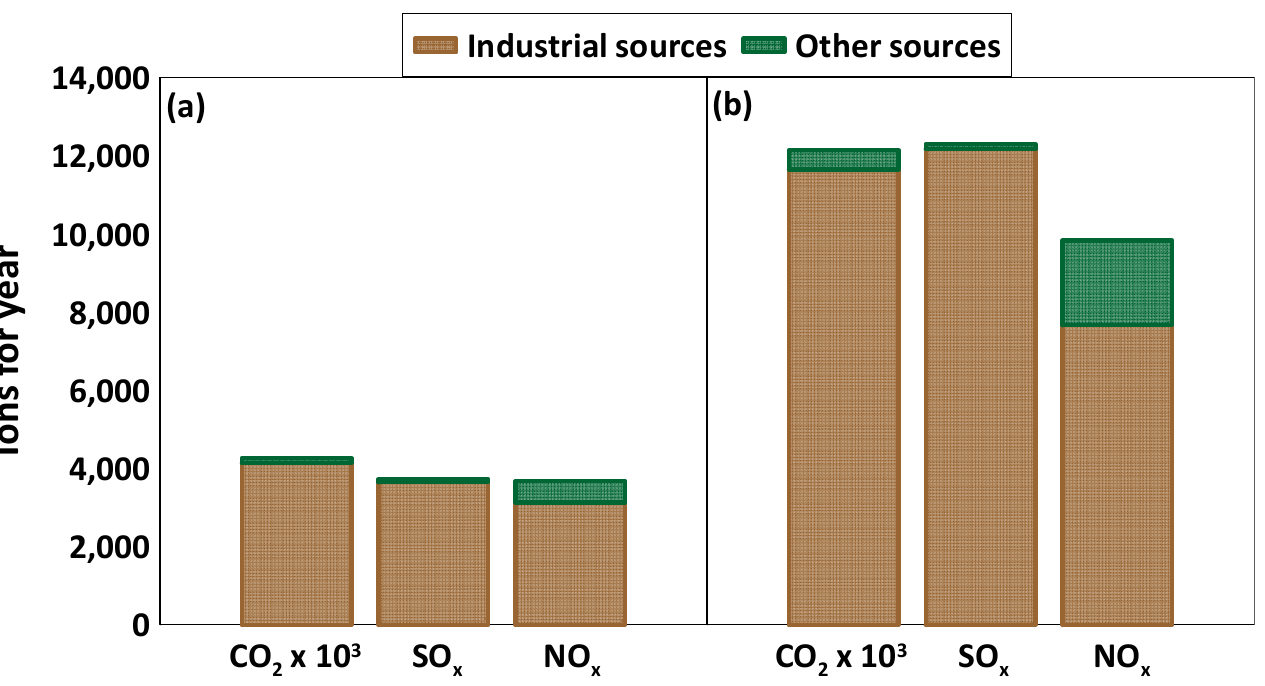
Figure 10. Gaseous species (CO 2 , SO x , NO x ) emissions and sources at Milazzo AERCA ( a ) and Priolo Gargallo AERCA ( b ) (ARPA, 2022, [62]).